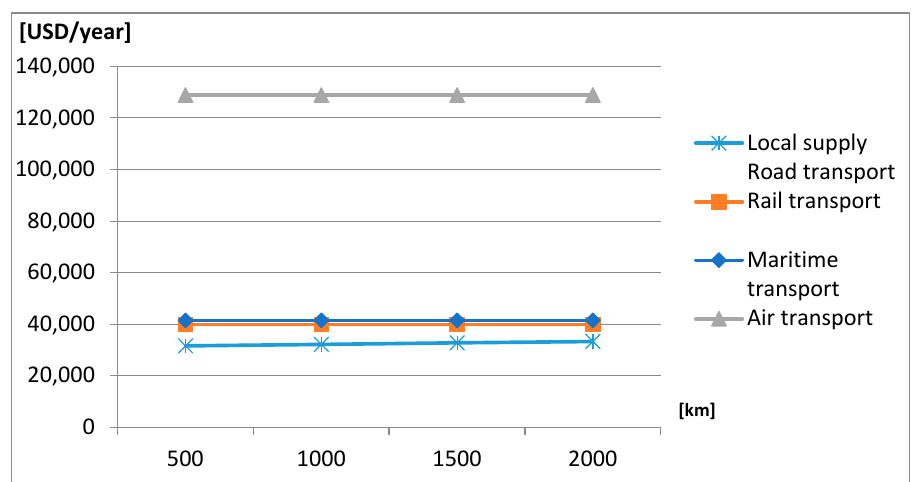
Figure 1. Results of simulations—impact on total costs (office products).